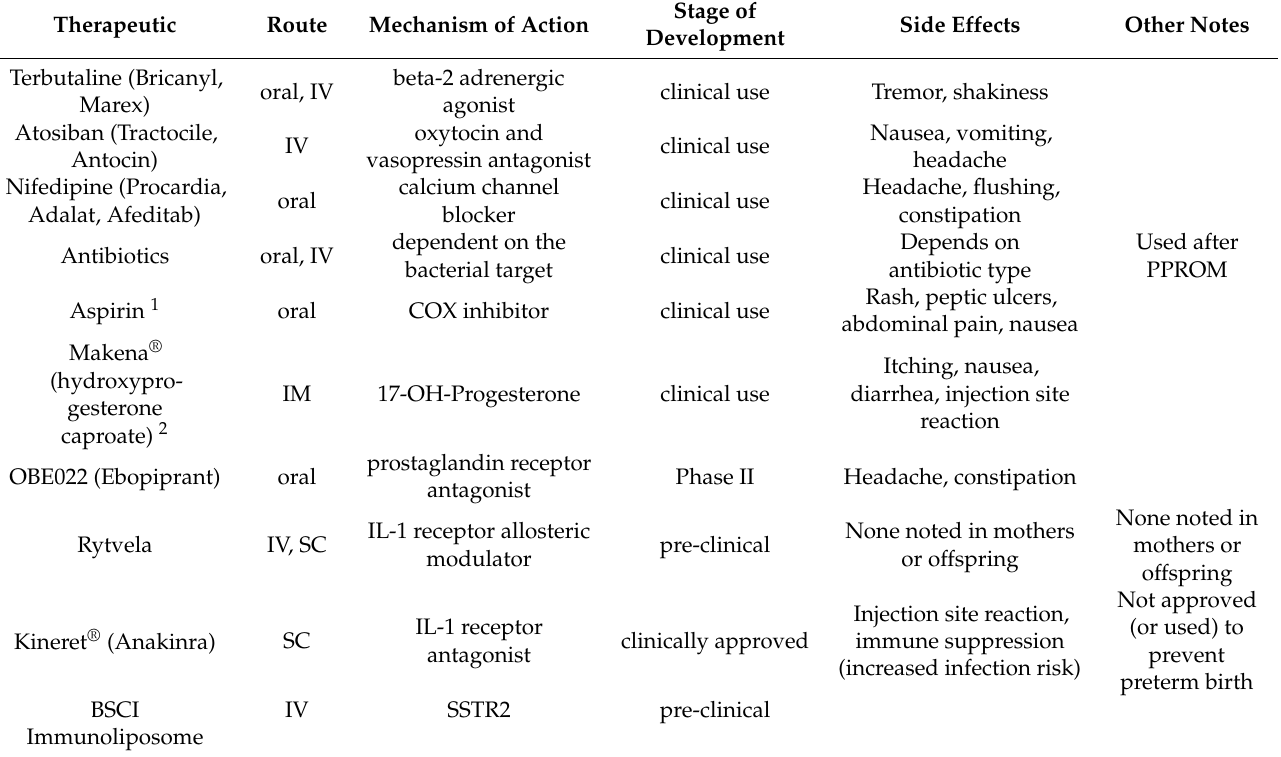
Table 1. Summary of preterm birth therapeutics.